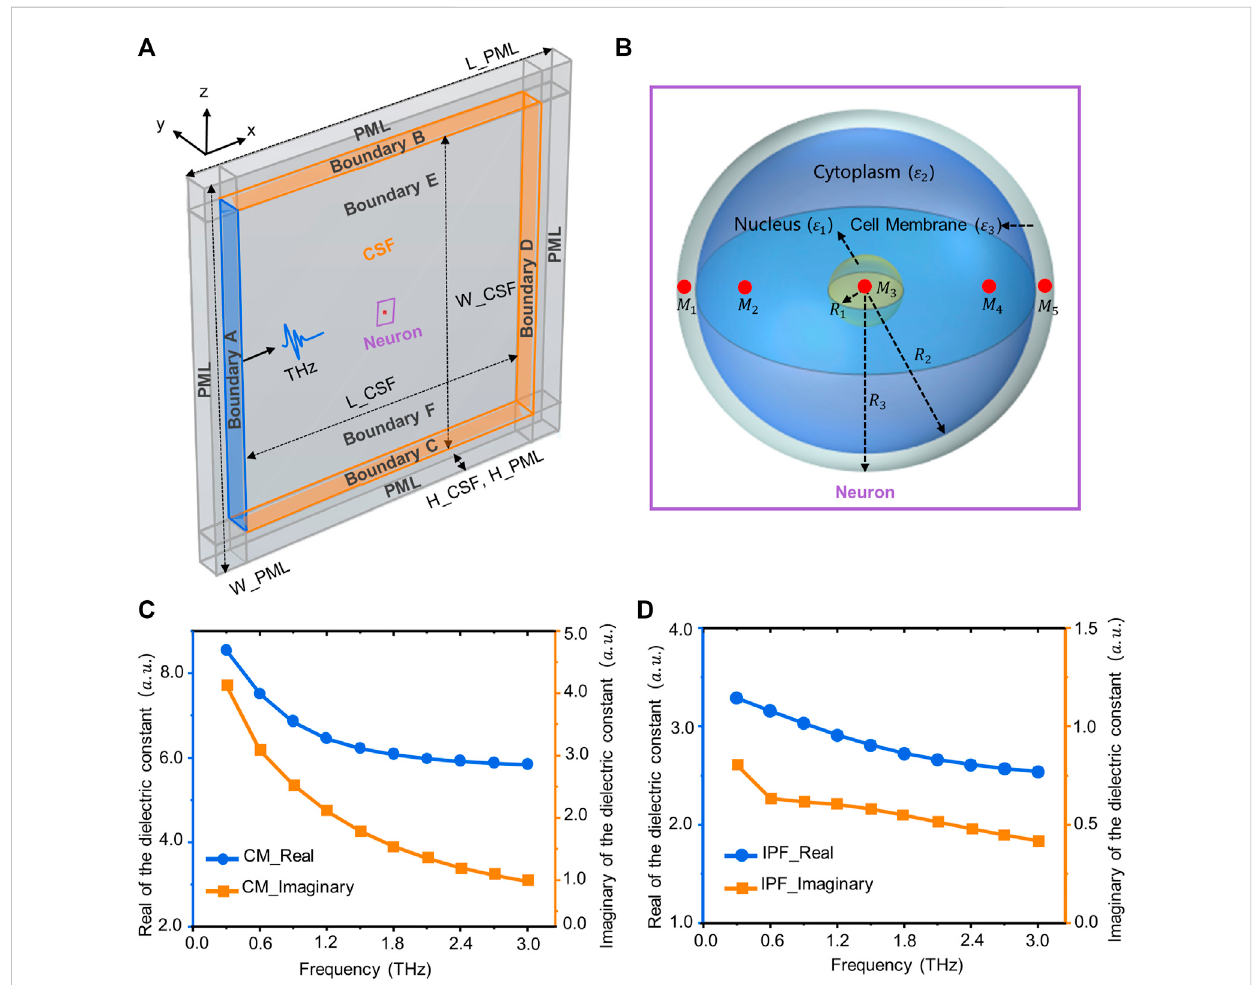
FIGURE 1 Simulation model and dielectric constant of biological tissue. (A) Terahertz wave transport and thermal effect model in the neuron, including neurons,terahertzsources,cerebrospinal fl uid,andPMLlayers. (B) Athree-dimensionalneuronalmodelconsistingofanucleus,cellmembrane(CM)and cytoplasm.Theredareaisthelocationofthesampling point(M 1 – M 4 ). (C) TherealandimaginarypartsoftherelativepermittivityoftheCM(3 – 3 THz). (D) The real and imaginary parts of the relative permittivity of the intracellular physiological fl uid